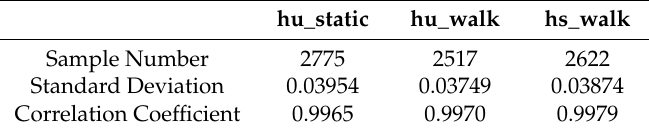
Table 4. Statistical analysis of pressure signals in three H-motions.